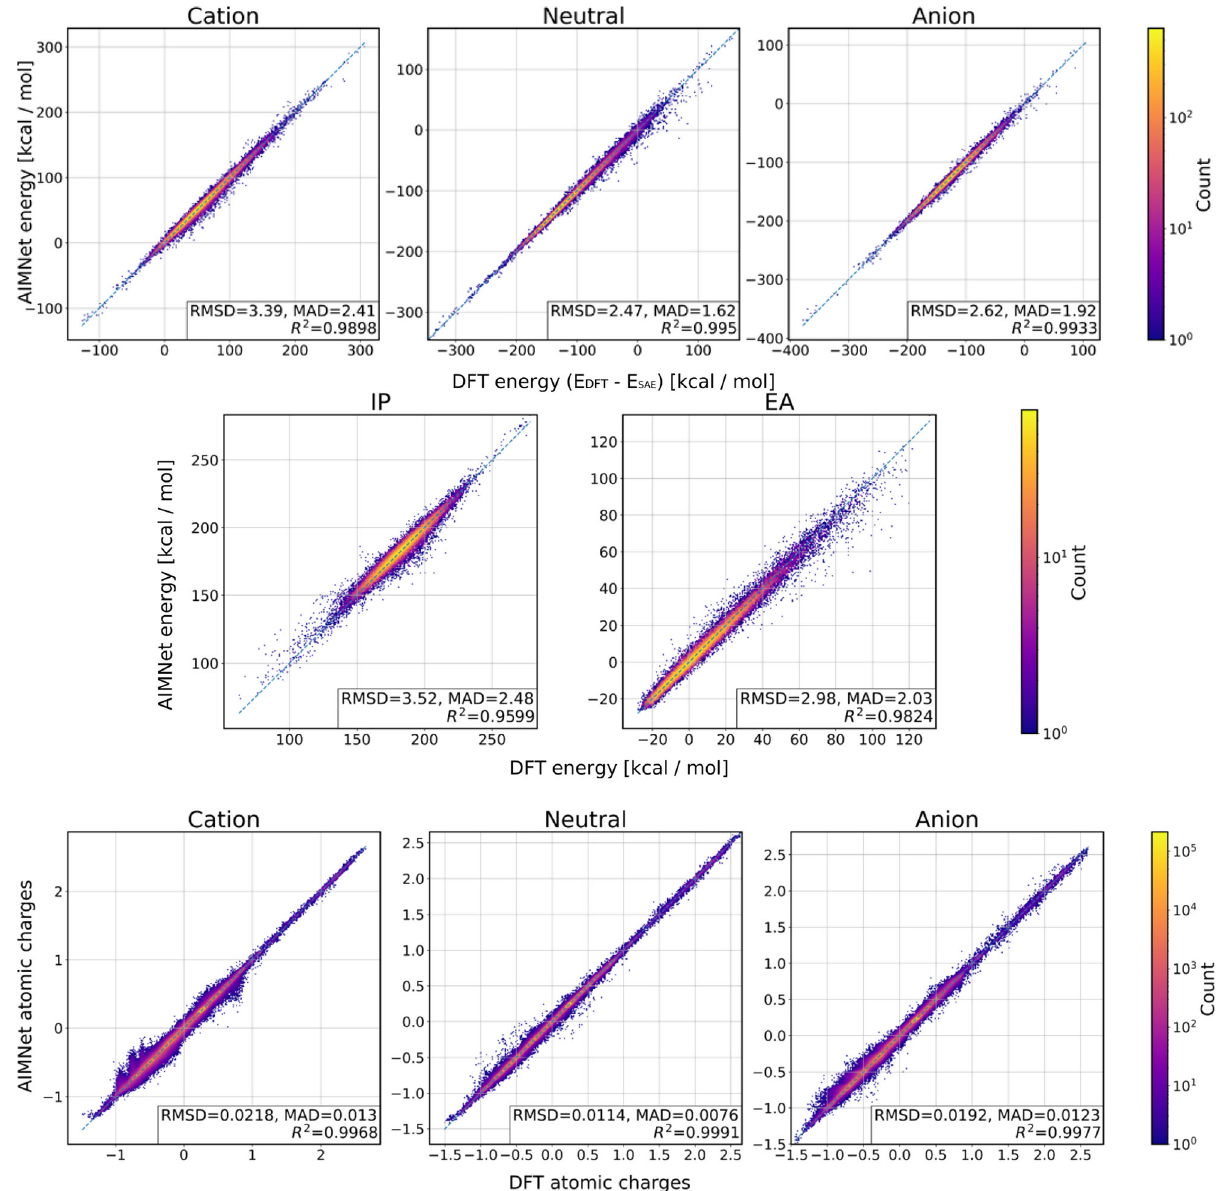
Fig. 2 Performance evaluation for AIMNet-NSE model. Correlation between DFT PBE0/ma-def2-SVP and AIMNet-NSE predictions for total molecular energies (top row), non-equilibrium vertical ionization potentials (IP), and electron af fi nities (EA) (middle row) and NBO atomic charges (bottom row) calculated for three charge states for Ions-16 data set. DFT total energies were shifted by the sum of atomic self-energies ( E SAE ) to allow a comparison for molecules with different compositions. Element-speci fi c E SAE calculated using linear regression, correspond to average atomic energies in the entire training data set that include all charge